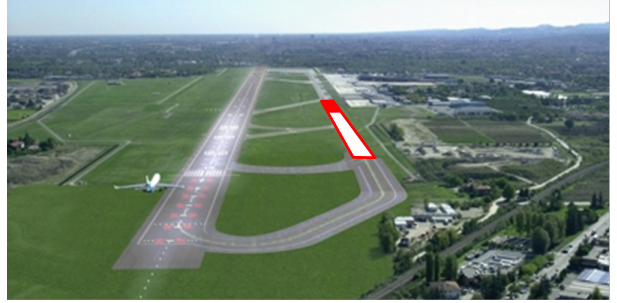
Figure 1: Rehabilitation interview of the taxiway at the Guglielmo Marconi airport of Bologna (Italy): area of the rehabilitation inter- view boxed in red and experimental segment filled in red (from